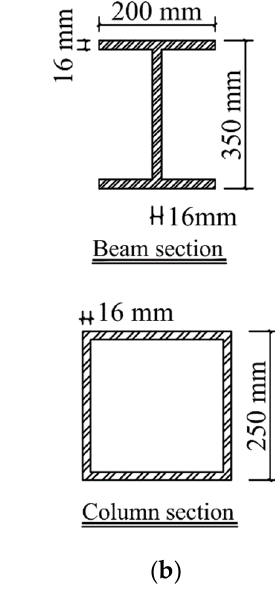
Figure 4. Five-storey steel frame. ( a ) Finite element model. ( b ) Cross-sections.